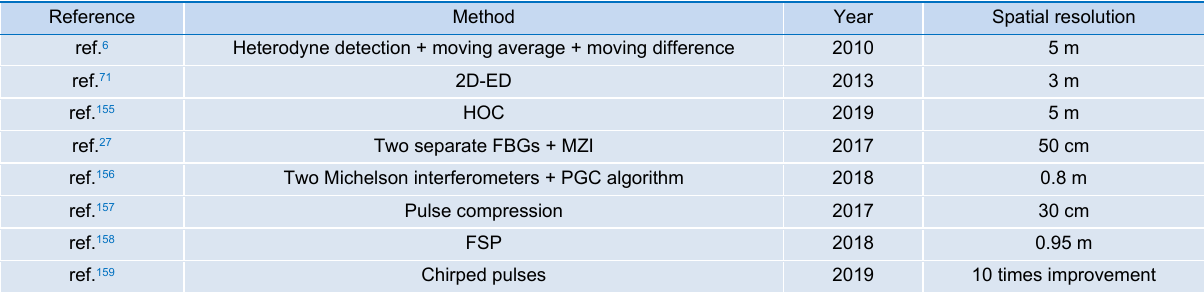
Table 4 | Research progress on improving spatial resolution in Ф-OTDR